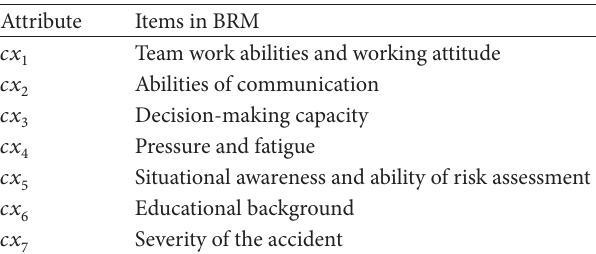
Table 3: Corresponding relationship between items in BRM and attribute.